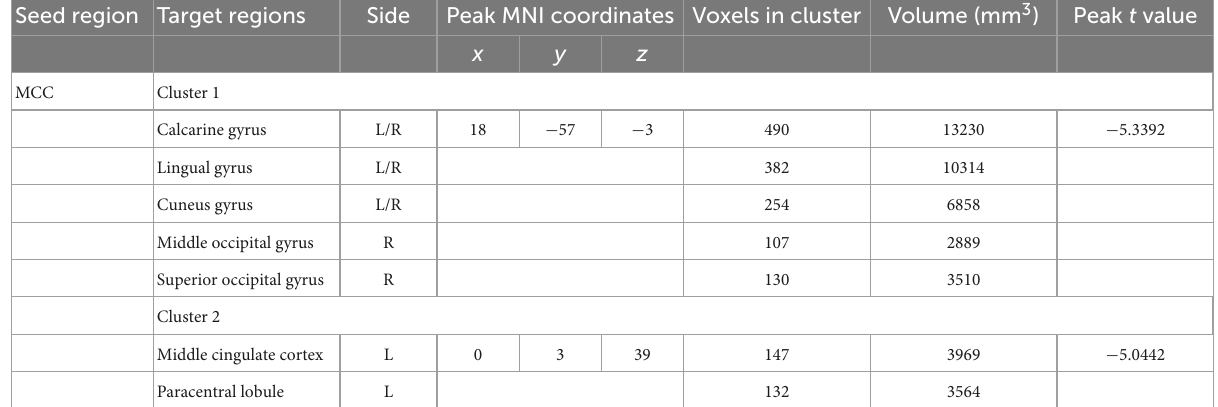
TABLE 4 Brain regions showing FC differences based on left MCC between the CTN patients and HCs. Seed region Target regions Side Peak MNI coordinates Voxels in cluster Volume (mm 3 ) Peak t